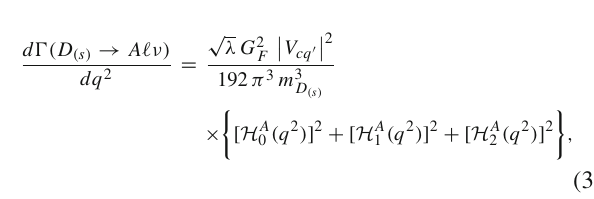
d (cid:17)( D ( s ) → A (cid:2)ν)